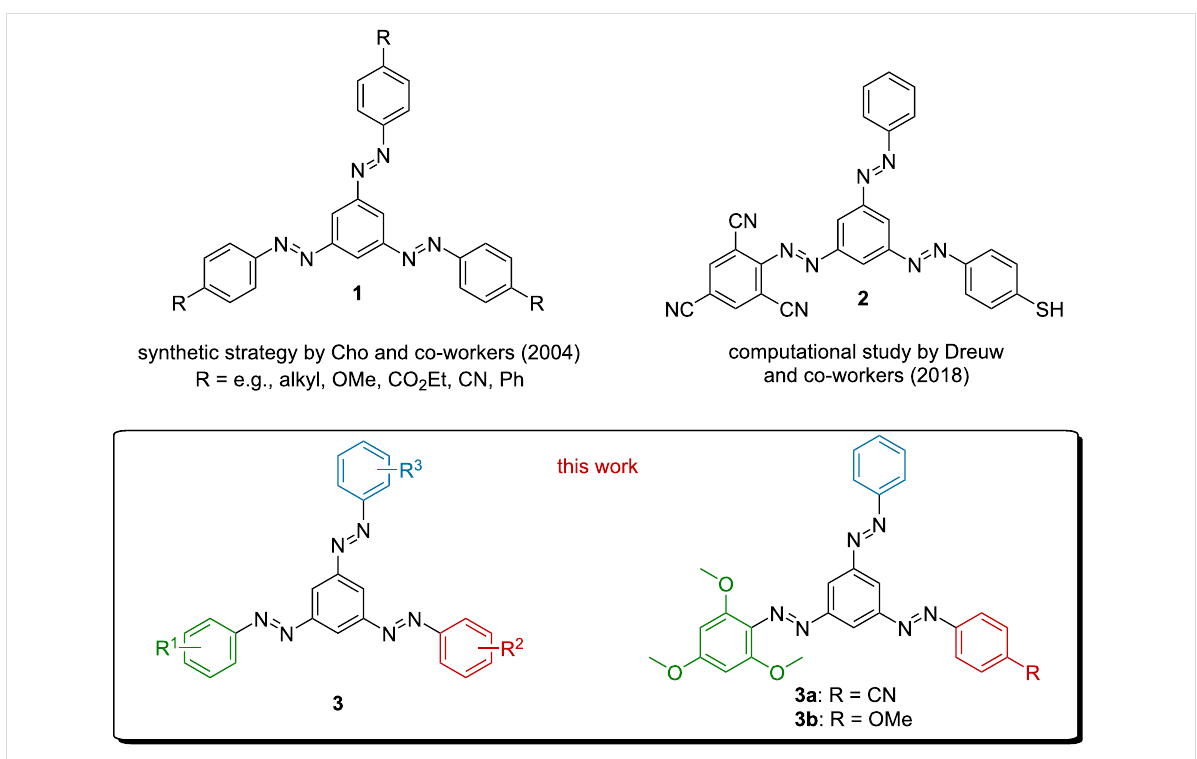
Figure 1: 1,3,5-Tris(arylazo)benzenes as individually switchable multistate photoswitches: previous [11,12] and present